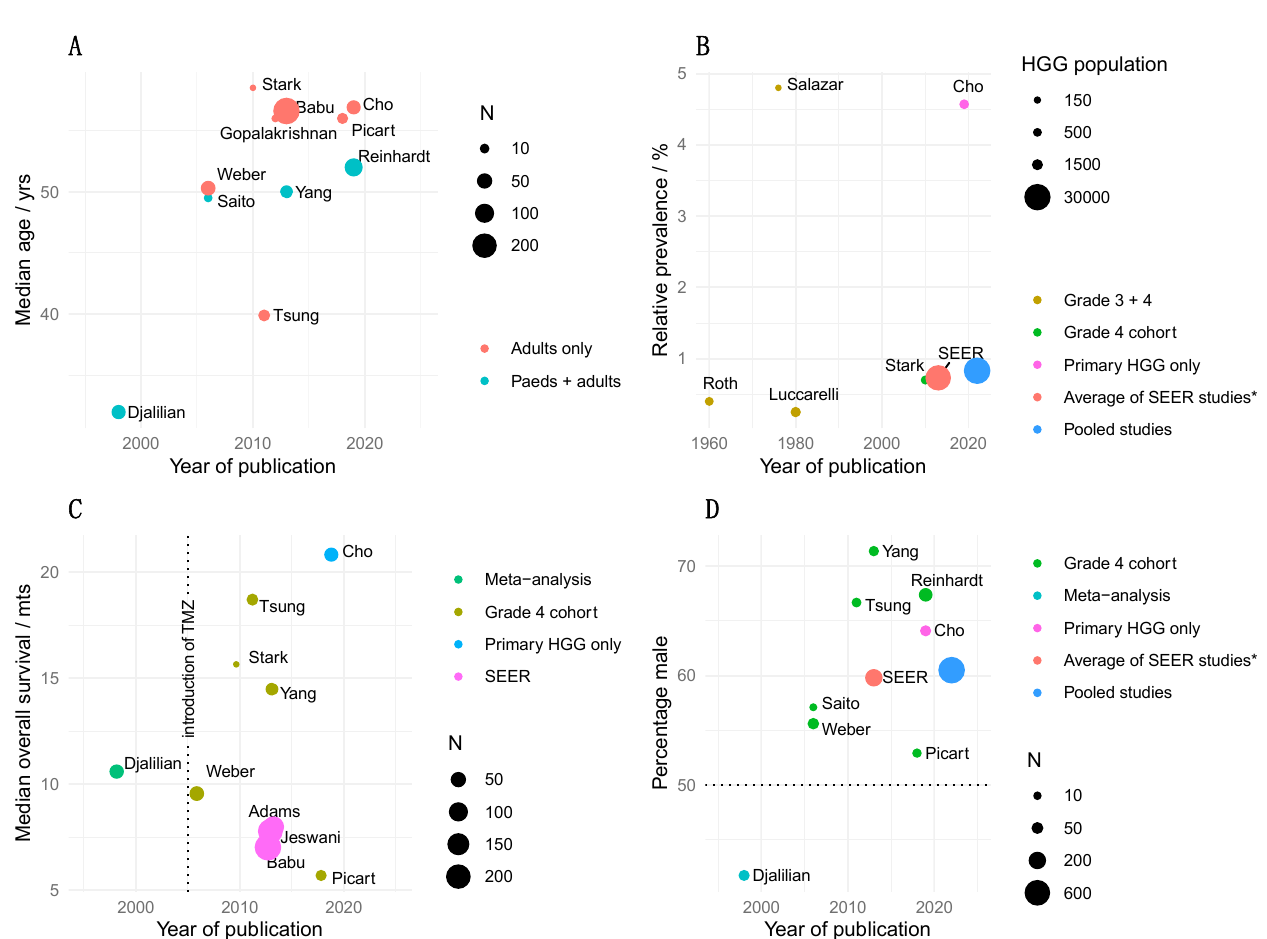
Figure 1. Epidemiology of cerebellar high-grade glioma. Reports are plotted against publication date and identified by the first author. ( A ) median age. ( B ) percentage of high-grade glioma tumors which are cerebellar. ( C ) median overall survival. ( D ) percentage of male patients. Older reports where high-grade glioma explicitly includes grade 3 and 4 tumors are noted. For ( B , D ), a pooled average (sky blue) of the reports is given at year 2022. N = number of patients; SEER = Surveillance, Epidemiology, and End Results; HGG = high-grade glioma. * Weighted average of Adams et al. [1], Jeswani et al. [4], and Babu et al. [9].